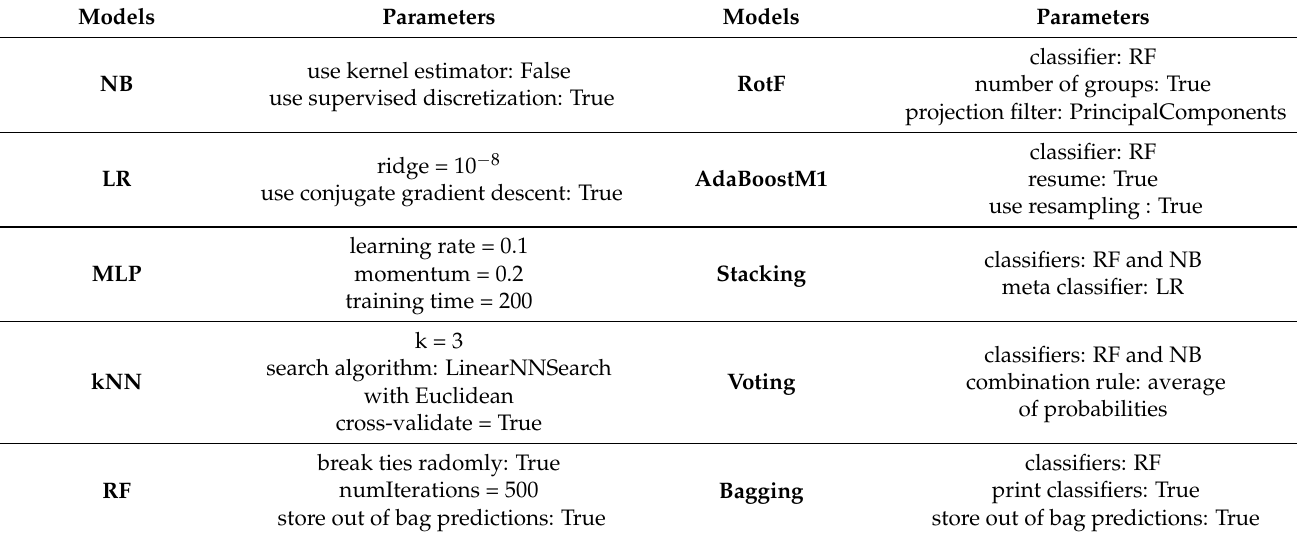
Table 3. Machine Learning Models’